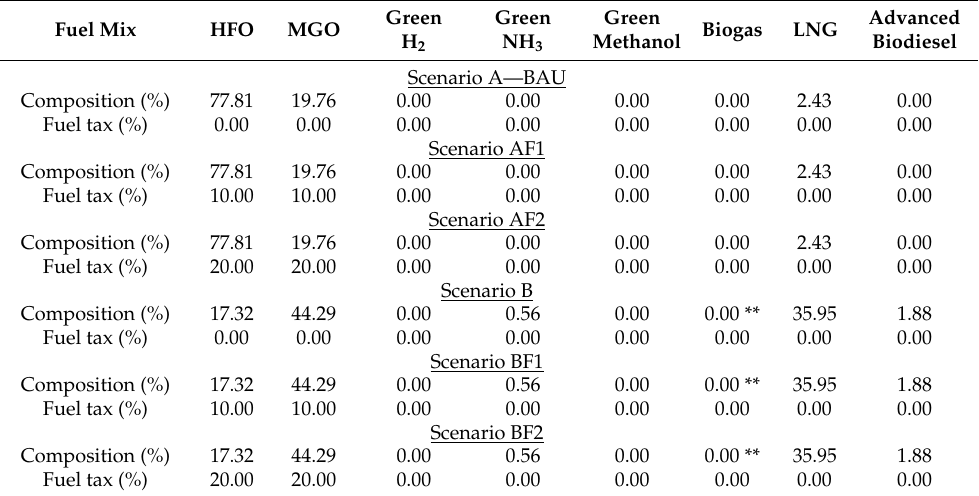
Table 5. Scenario A: BAU DNV fuel maritime mix at 2018 and Scenario B: DNV fuel maritime mix at 2030, fuel mix obtained from [32,33]. ** Very small contribution, and therefore, considered zero. Note that “electricity from grid” is ignored in the energy mix; hence, mix is readjusted. Scenarios F1 and F2 refer to fuel tax scenarios based on the relevant fuel maritime mix.